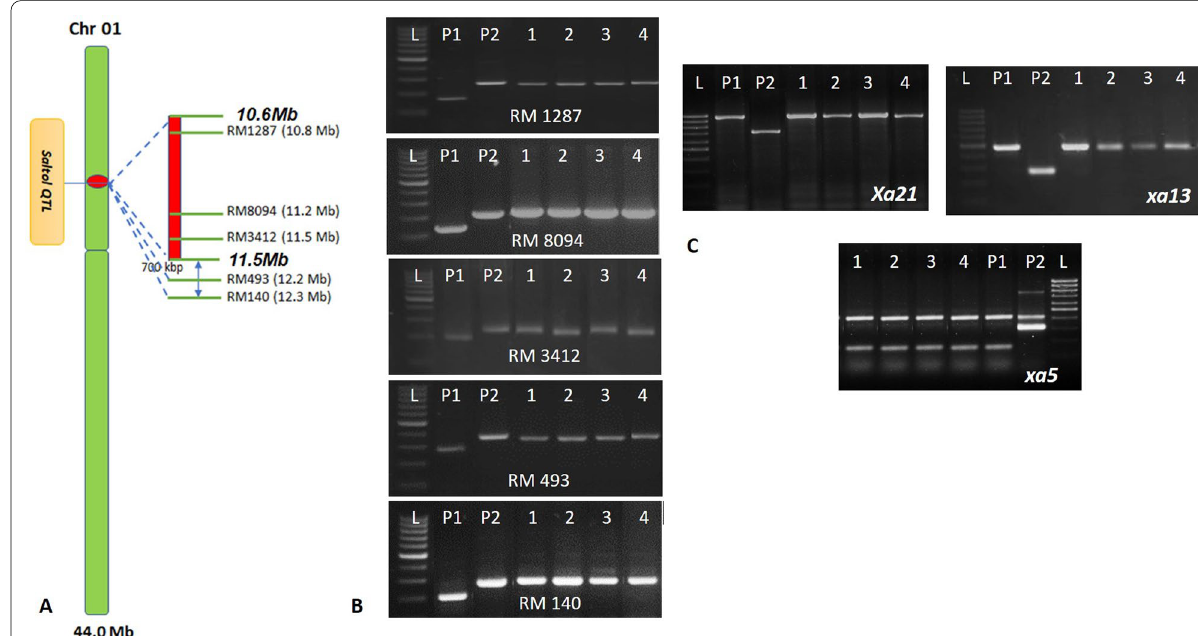
Fig. 1 A : Representation of Saltol QTL region and the markers spanning along the target region B - Confirmation of promising BC 3 F 4 lines with the five markers spanning the Saltol QTL. L- 100bpLadder; P1- ISM, P2- FL478; Samples 1–4–Introgression lines of ISM. C- Confirmation of promising BC 3 F 4 lines for BB resistance genes ( Xa21, xa13 and xa5 ). L- 100bpLadder; P1-ISM, P2- FL478; Samples 1–4–Introgression lines of ISM. 1- RP6287-43; 2-RP6287-88; RP6287-12;